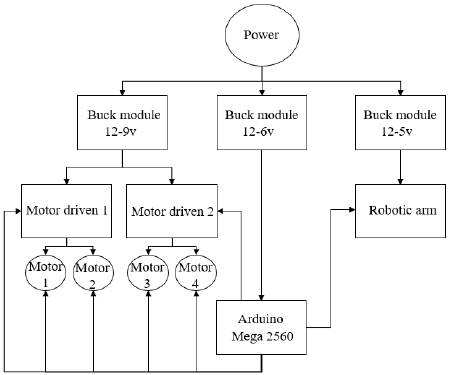
Figure 8. Circuit connection diagram.